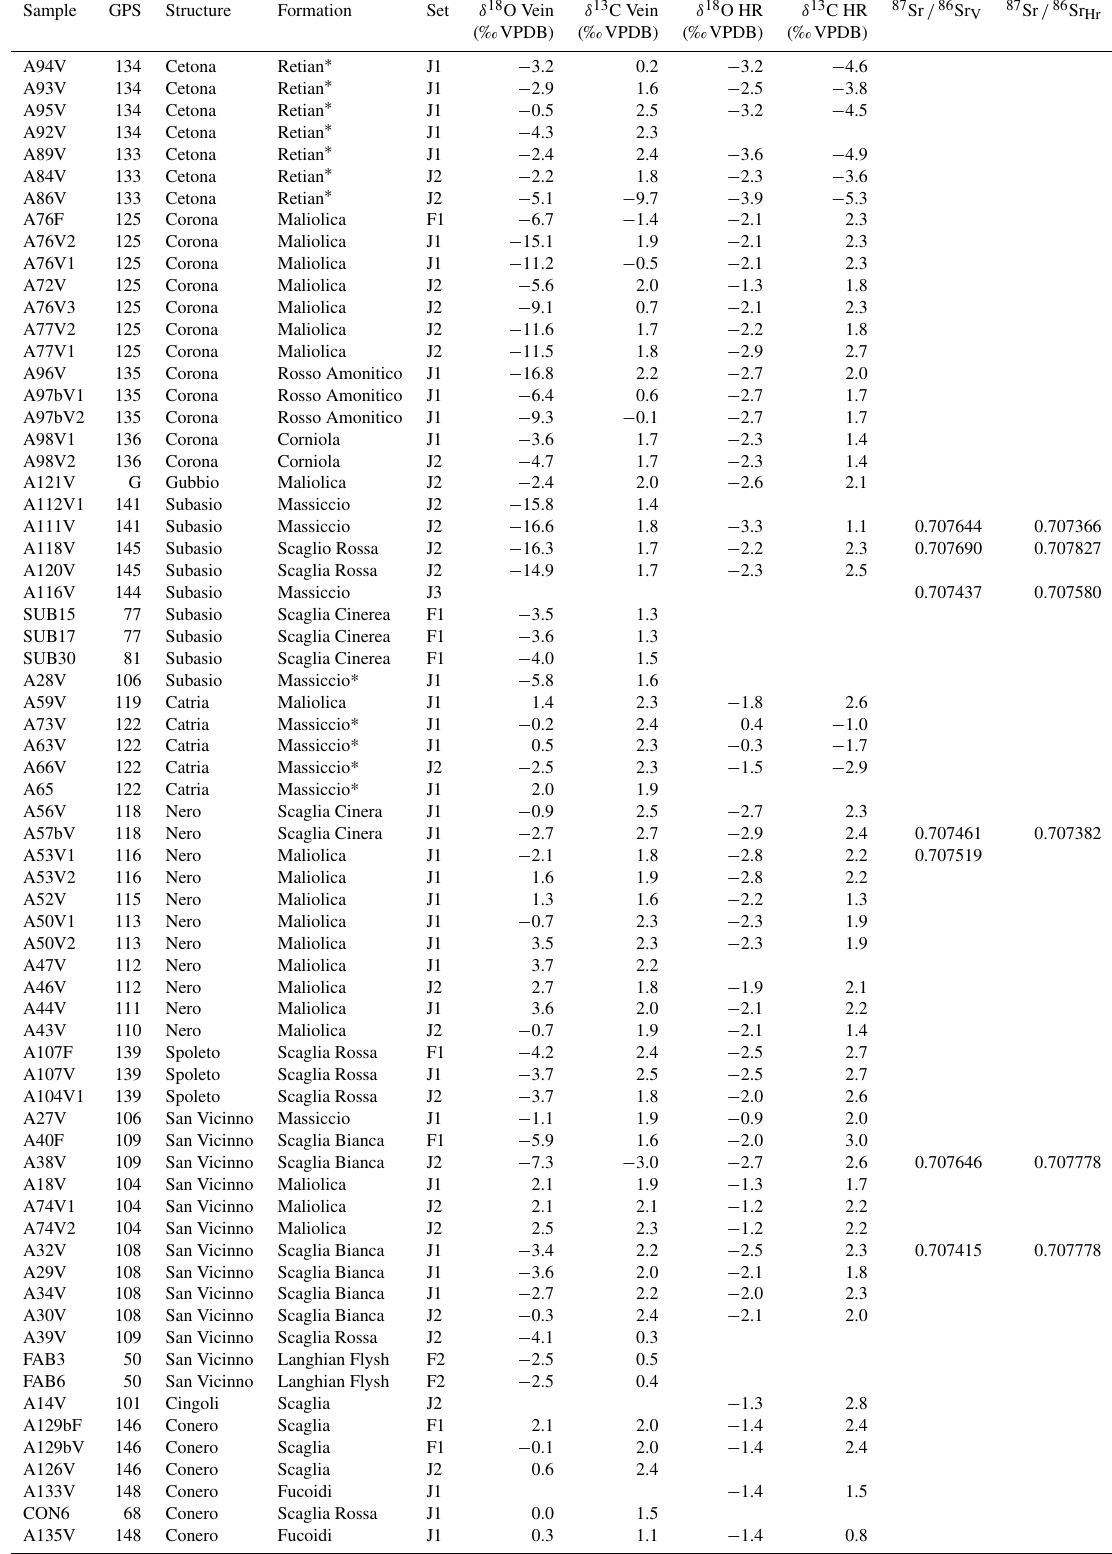
Table 2. Results of stable isotopic analyses of O, C, and 87 Sr / 86Sr .